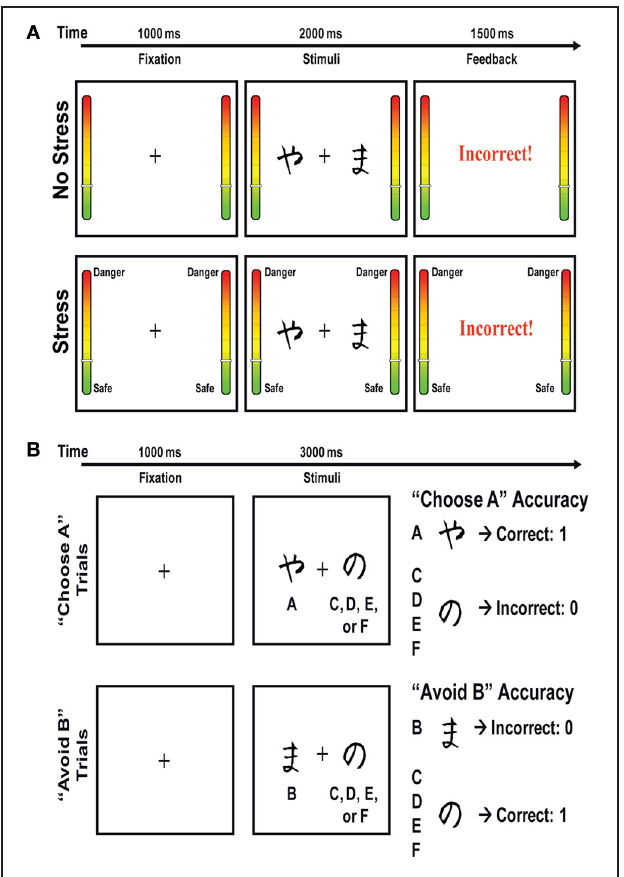
FIGURE 2 | (A) Schematic representation of the training phase of the Probabilistic Stimulus Selection Task, which was performed under stress or no stress conditions. In the no-stress condition, every time a red border flashed, participants were instructed to press a foot pedal to indicate they were attending to the task. In the two stress conditions, participants were told that the border flashing red indicated a shock might occur in the ensuing 15–30s. In the controllable stress condition, participants were further instructed that they could reduce (though not fully eliminate) the likelihood of the shock if they pressed the foot pedal when they saw the red border cue. In contrast, participants in the “uncontrollable stress” condition were instructed to press the foot pedal to indicate they were attending to the task. (B) Schematic representation of the test phase of the Probabilistic Stimulus Selection Task. No stress was presented during this